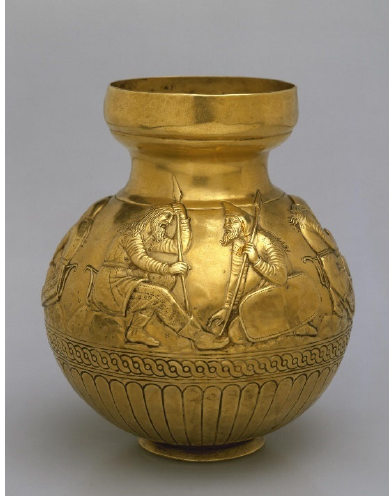
Figure 24. Vessel depicting Scythians (SHM inv. no. KO 11); gold; Kul’ Oba, near Kerch, Crimea; late 4th century BC. [Image is used from www.hermitagemuseum.org (accessed 9 November 2022),